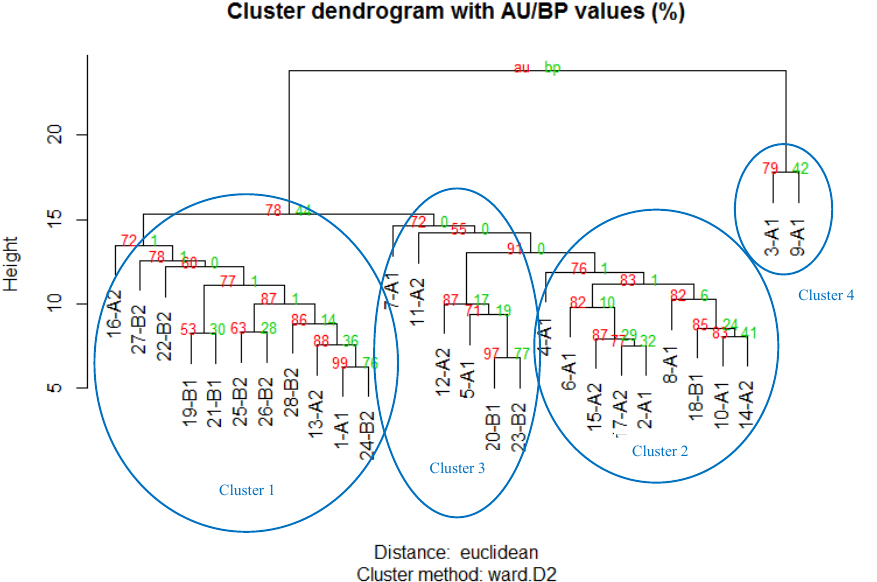
Figure 2. Cluster analysis of the 28 Spanish learners (including their corresponding CEFR language proficiency level) based on the percentages of canonical and non-canonical classifications per target vowel obtained from the acoustic